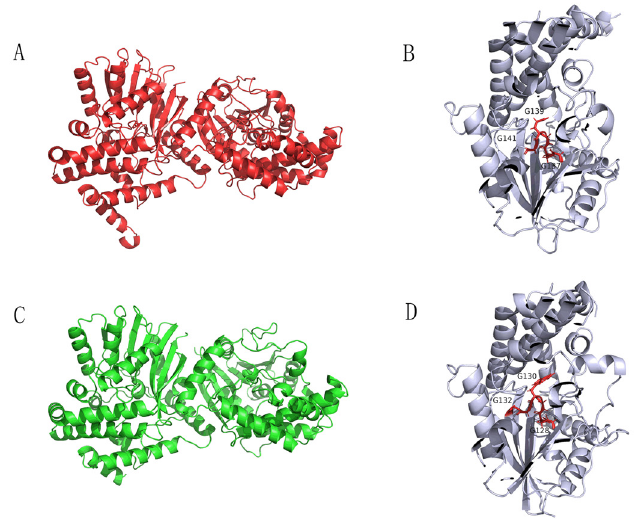
Figure 7. Protein structure diagrams. The proteins were visualized in ribbon representation. Dimeric structure ( A ) and its active site ( B ) of Tetrahydroisoquinoline N-methyltransferase from Coptis japonica. Dimeric structure of Tetrahydroisoquinoline N-methyltransferase in Methylotenera ( C ) and its active site ( D ).